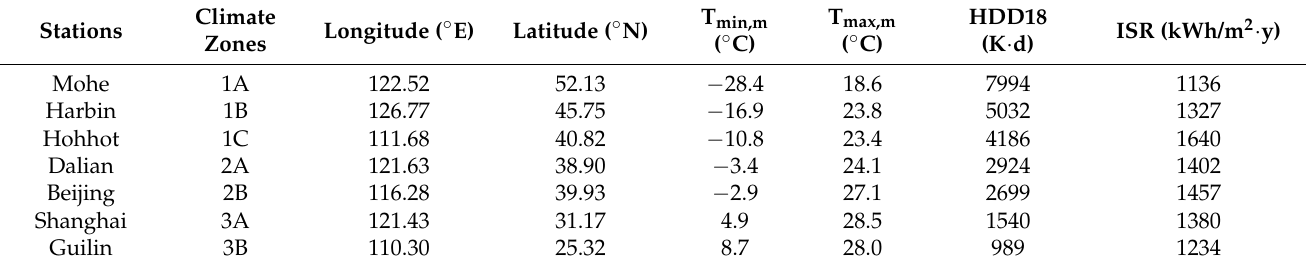
Figure 6. Geographic locations of the selected cities. Table 7. Climate zones, representative cities, and related weather indexes.